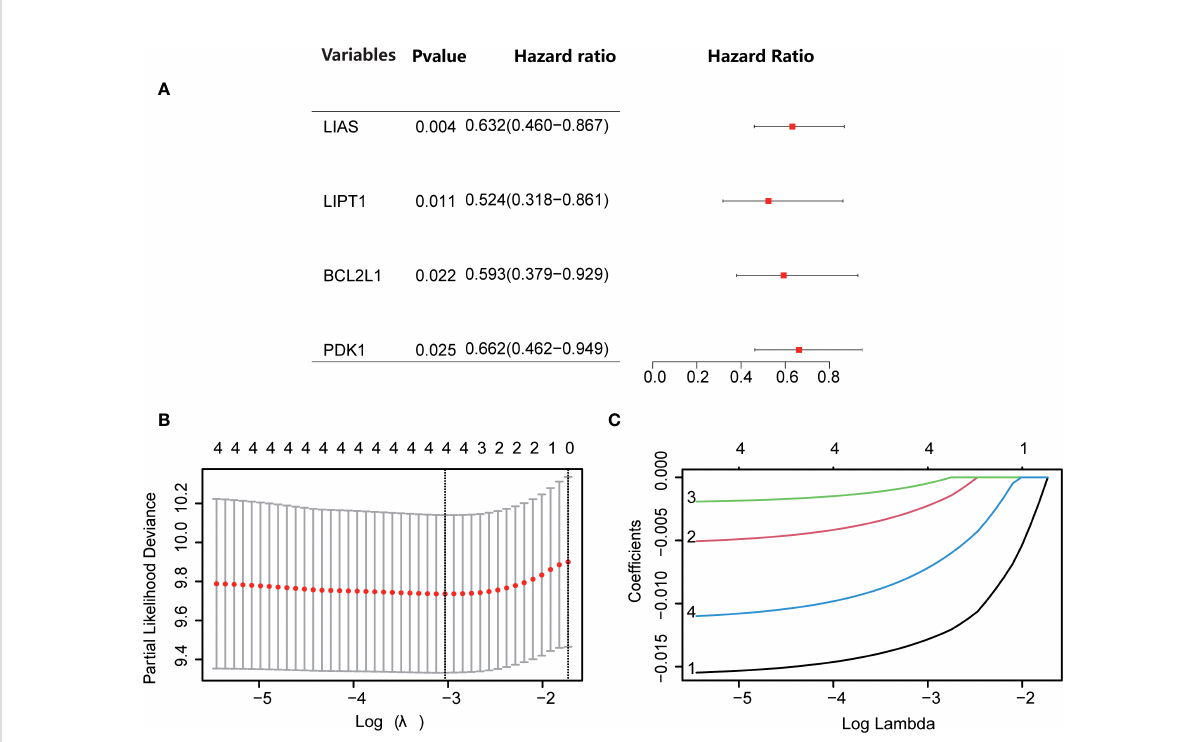
FIGURE 1 Screening for Cuproptosis-Related Genes. (A) Forest plot showing the results of univariate Cox regression analyses. (B, C) LASSO analysis with minimal